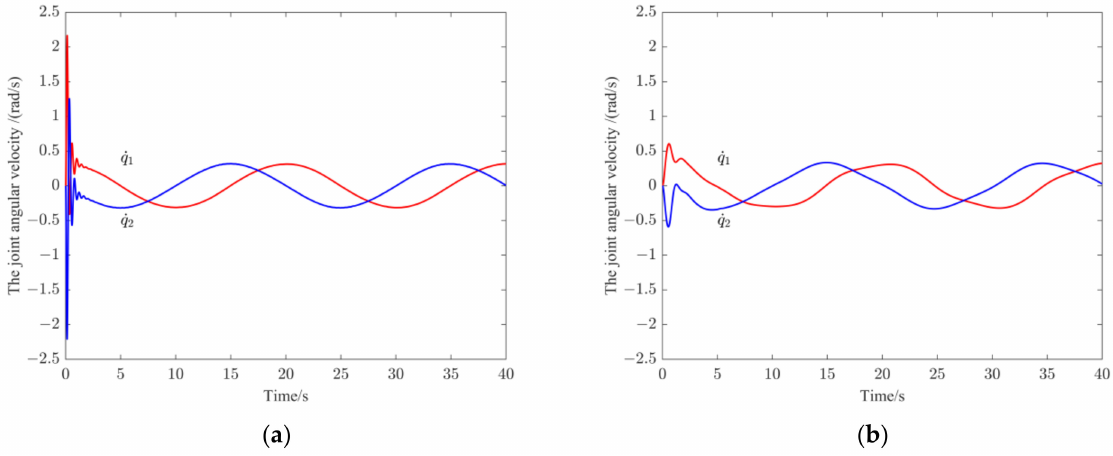
. q . ( a ) RBFTHC, ( b ) CTC. θ